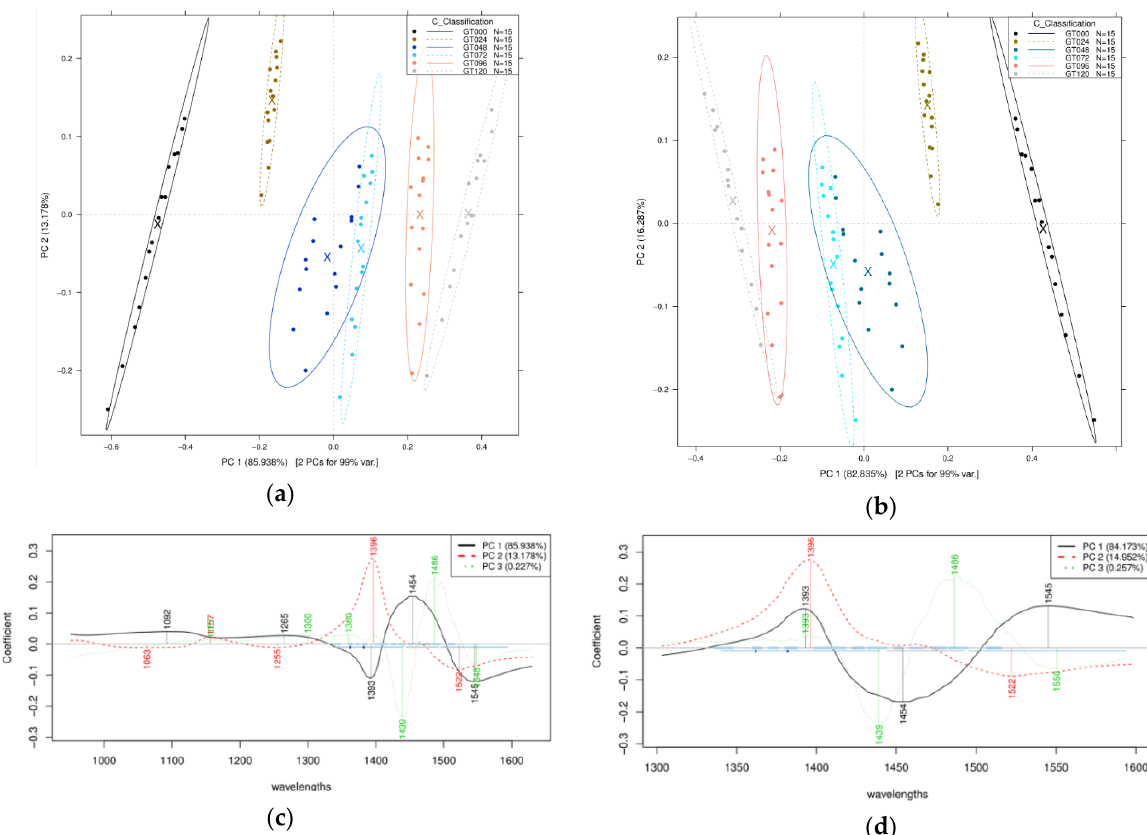
Figure 3. Principal component analysis (PCA) on the entire Near-Infrared Spectroscopy (NIRS) spectral data of the mung bean sprout extract after Savitzky-Golay smoothing (SG) and standard normal variate (SNV) pretreatment of the spectra: ( a ) Score plot within 950–1630 nm wavelength interval, ( b ) score plot within 1300–1600 nm first O-H overtone wavelength, ( c ) principal components (PC) loadings plot within 950–1630 nm wavelength interval, and ( d ) PC loadings plot within 1300–1600 nm wavelength interval.